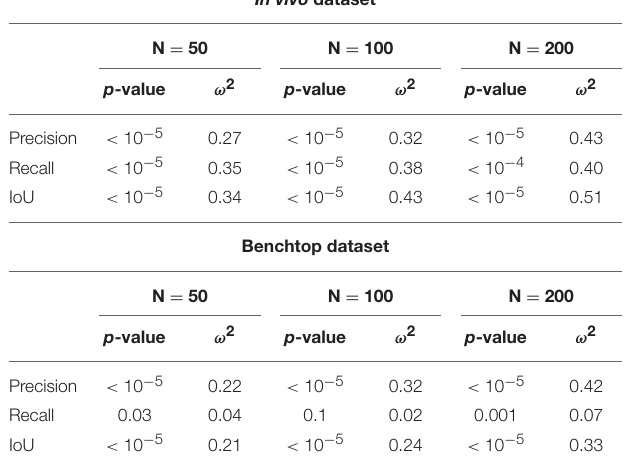
TABLE 1 | Summary of ANOVA results and effect size for optimization type factor O , for the considered metrics and the three sets of parameters for the PSO. In vivo